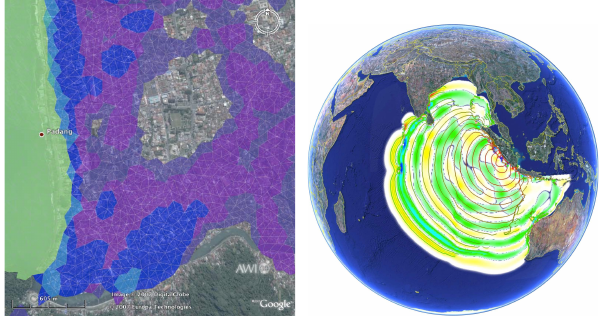
Fig. 4. Detail of a grid and inundation flow depth in Padang, West Sumatra, Indonesia, used in the operational tsunami propagation and inundation model TsunAWI (left), and a typical propagation example for the Indian Ocean (right).